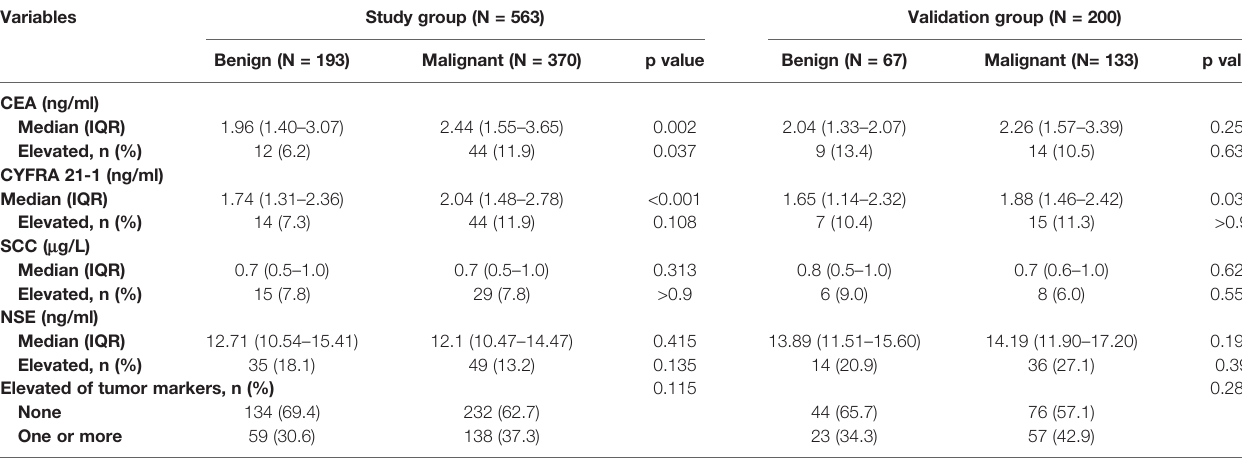
TABLE 3 | Serum tumor markers according to lung cancer status in the study and validation datasets. Variables Study group (N = 563) Validation group (N =